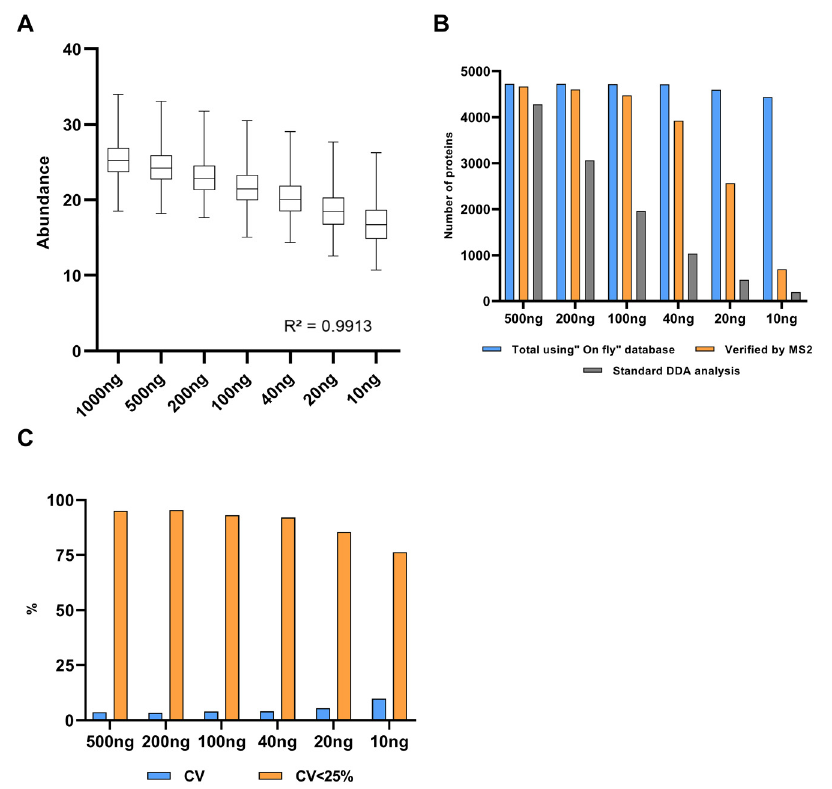
Figure 4. A HeLa experimental model for MS1 feature transfer evaluation. ( A ) Linearity analysis of protein abundance depending on the protein amount analyzed. Abundance: Log2 (intensity). ( B ) Comparison of the results obtained by MS1t, DDA, and DIA analyses (verified by MS2). ( C ) MS1t coefficient of variation evaluation throughout the dilution points. Blue bars represent the median CV values of dilution points, and orange bars show the percentages of proteins with cv lower than 25%.